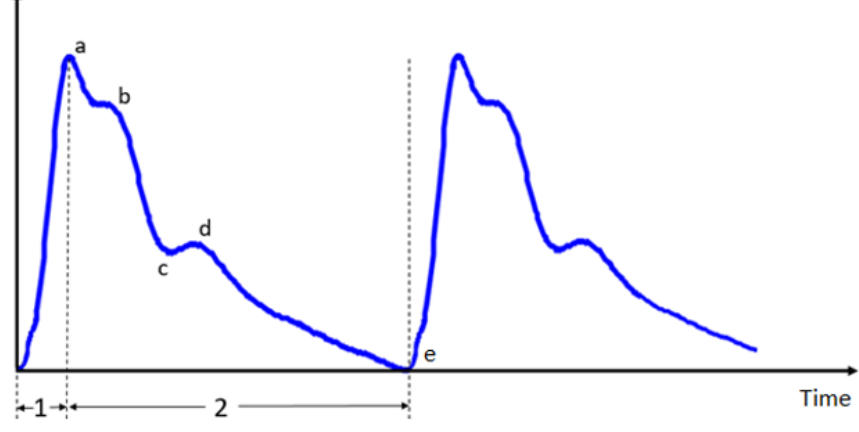
Figure 2. Waveform and characteristic points of the pulse wave.